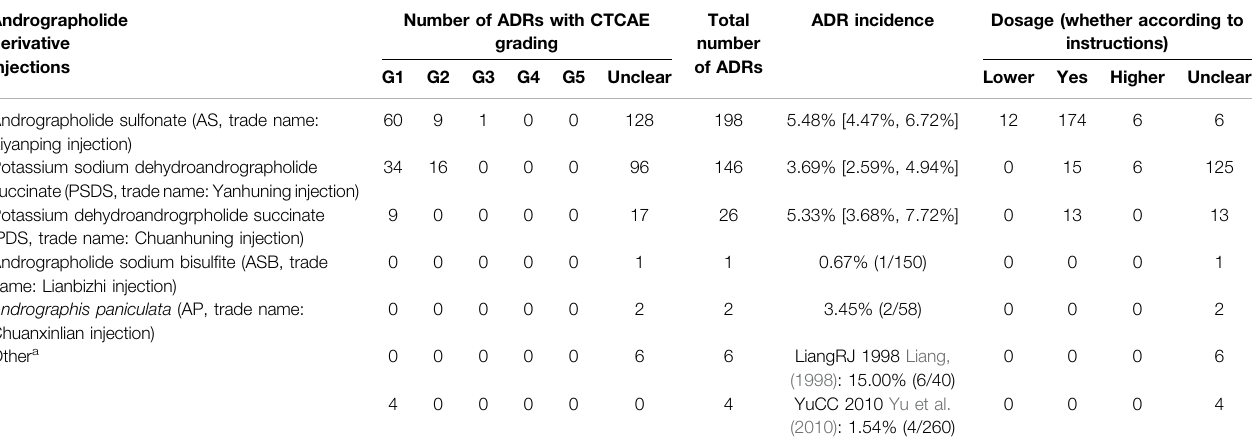
TABLE 1 | ADR incidence of andrographolide derivative injections.